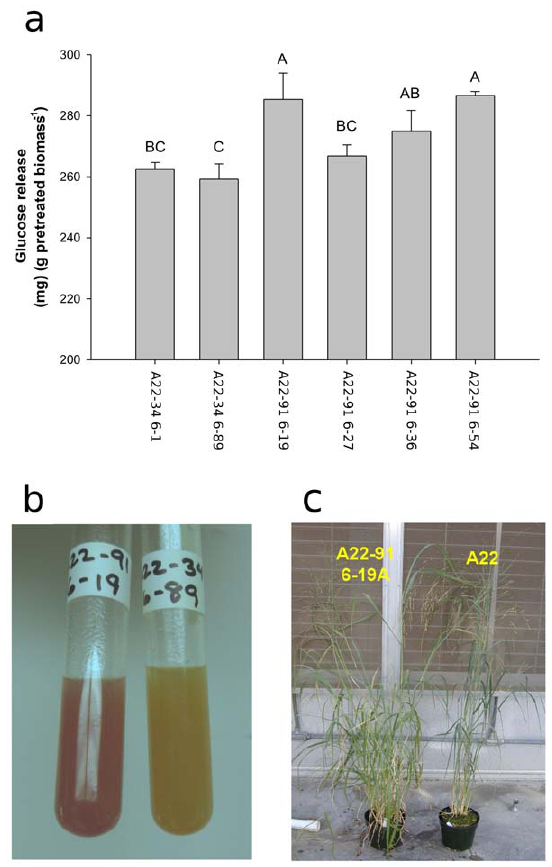
Figure 5. Altered susceptibility to enzymes and composition of the cell wall in CAD silenced lines. ( a ) Glucose release from pretreated pWBVec8 transformed lines A22-34 6-1 and A22-34 6–89 on the left and selected pEC129 transformants (right) expressed as mg glucose per gram dried sample as a result of treatment with cellulclast and b -glucosidase. Error bars indicate standard error of the mean (n=3). Samples with the same letter located above the bars are not significantly different. Results shown are the mean of three cellulose digests on separate pretreatments. ( b ) Photograph of phloroglucinol stained ground cell wall extracts from CAD-silenced line A22-91 6–19 (left) and A22-34 6–89 (right). ( c ) Appearance of A22-91 6–19 (left) relative to control untransformed line A22 (right) grown in the greenhouse.